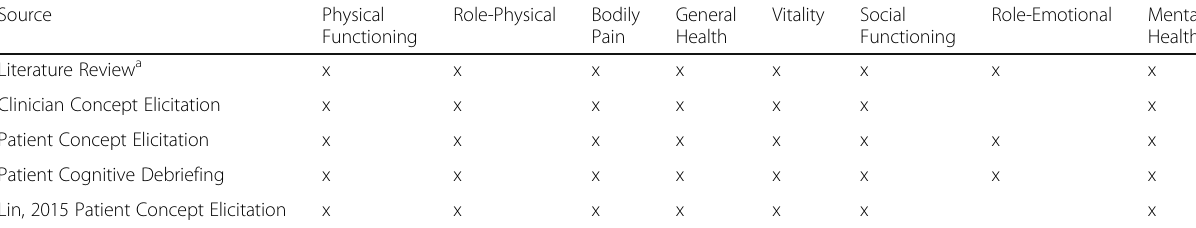
Table 5 Areas of HRQoL impacted by AL amyloidosis mapped onto SF-36v2 domains